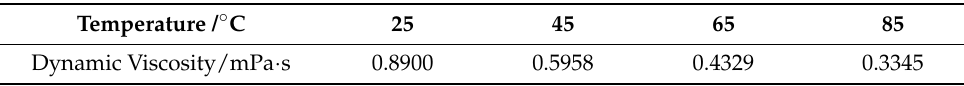
Figure 7. Variation curve of dynamic viscosity at different temperatures. Table 1. Dynamic viscosity at different